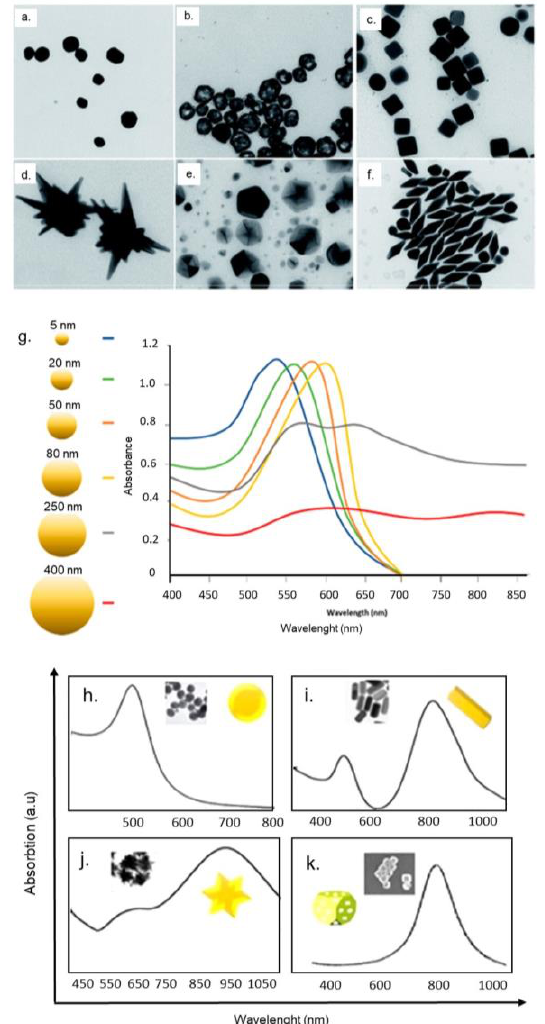
Figure 1. ( a – f ) Representative TEM images of Au nanomaterials having different shapes. Reproduced with permission from [22], Copyright , The Royal Society of Chemistry, 2017. (g ) Different localised surface plasmon resonance (LSPR) tuning the size of Au NPs [36] and shape ( h – k ). Reproduced with permission from [37], Copyright Elsevier, 2019